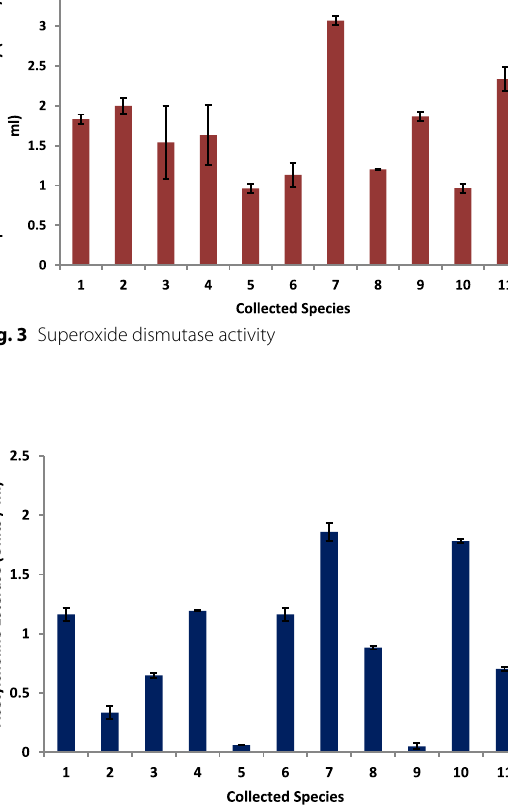
Fig. 4 Acetylcholine esterase activity